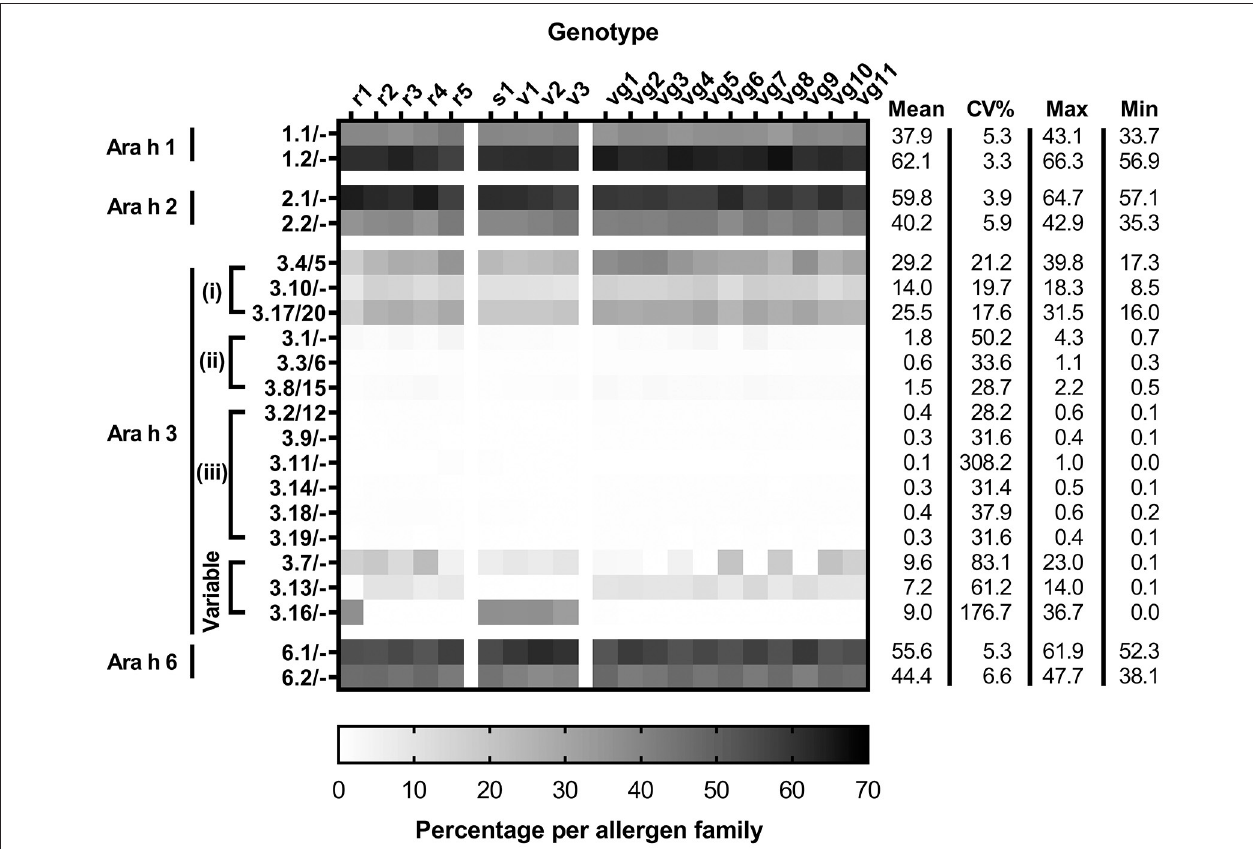
FIGURE 3 | Isoform distributions of Ara h 1, 2, 3, and 6 per genotype determined by unique peptide quantitation. Allergen quantitation is expressed as the percentage of allergen protein [allergen (g)/total protein (g)] per allergen family. Subgroupings of Ara h 3 include (i) high-abundance, (ii) mid-abundance and (iii) low-abundance. Each measurement from two biological replicates, which had two technical replicates for each peanut genotype, includes the mean, percent coefficient of variation (CV%), maximum, and minimum